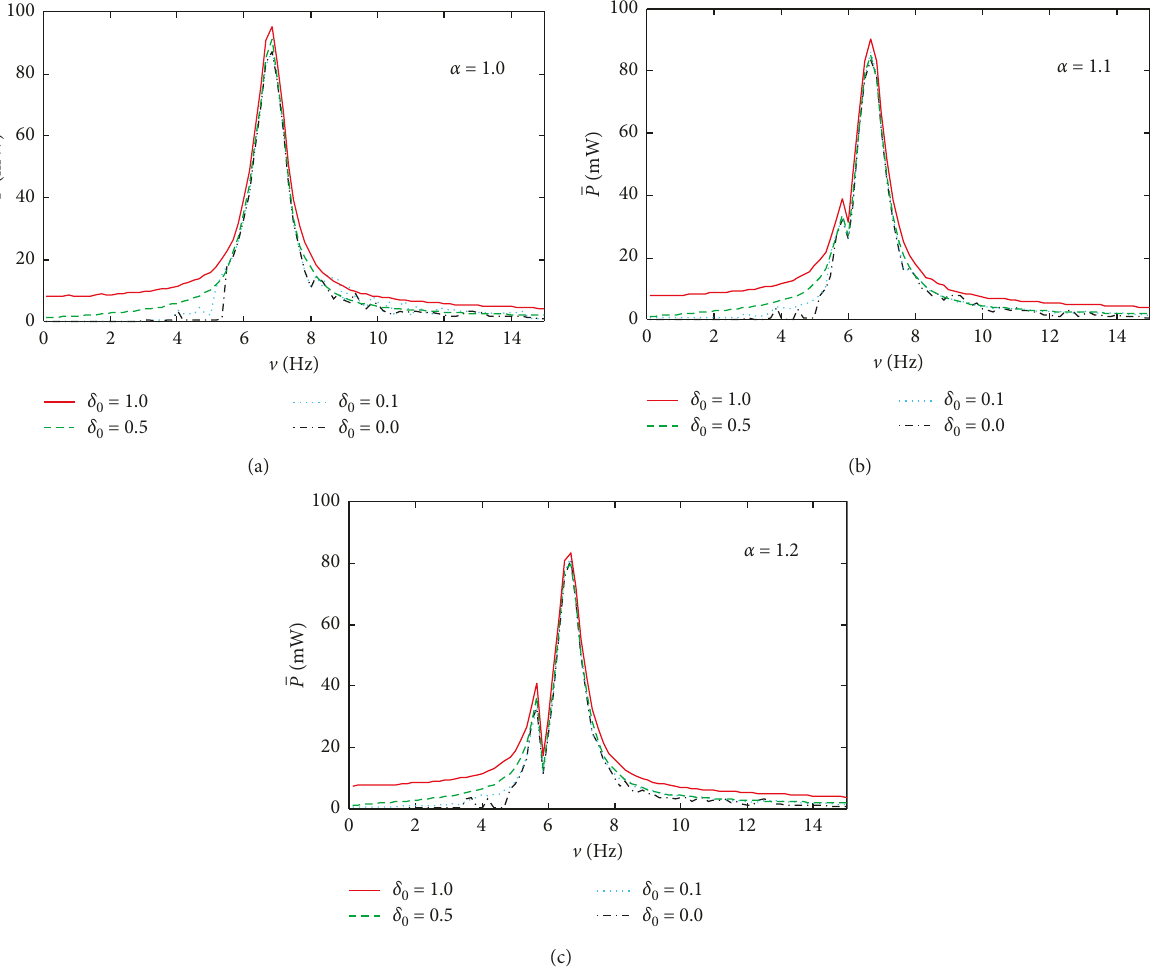
Figure 4: The mean power generated on the electric load R as a function of frequency ] for different values of the mass disproportion parameter α and for different values of the stochastic factor δ